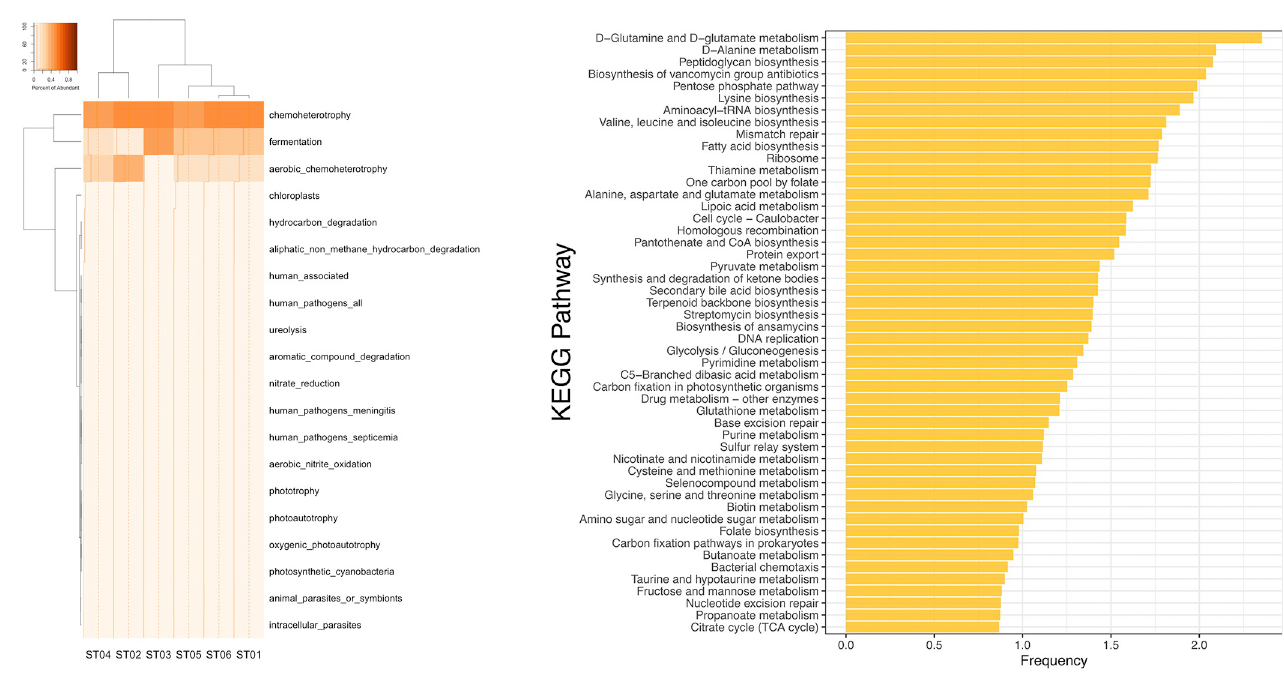
Fig 3. Bacterial functional gene prediction analysis from the gut of T . pagdeni : (a) FAPROTAX based on the relative abundance of bacterial taxa. (b) KEGG pathway entries with the top 50 ranking from the most frequent to the least.